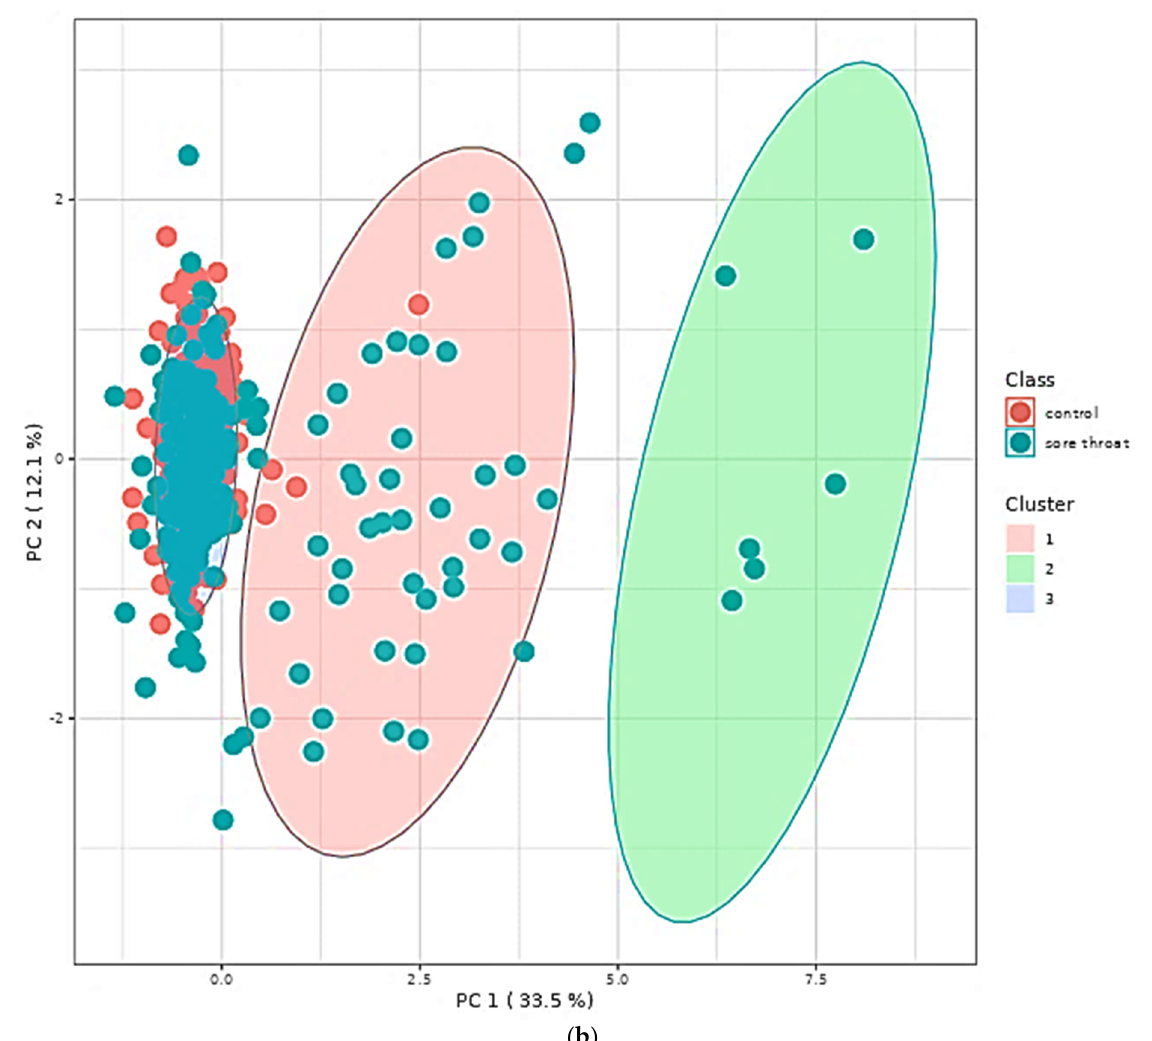
Figure 7. ( a ) Further segregation of the factor analysis (FA)-defined host source metabolite PC1 component (Ref. [1]) into two sub-components of 10 variables each via a secondary sPLS-DA strategy: PC2 versus PC1 and PC1 versus PC2 two-dimensional (2D) scores plots of results arising from this analysis of the acute sore throat disease dataset, with n = 480 participants (240 sore throat-positive, 240 age-matched healthy controls) and 31 1 H NMR-assigned biomolecules. Model 2 variance contributions for PC1 and PC2 were 26.9 and 11.2%, respectively. ( b ) PC2 versus PC1 2D scores plot of a composite PCA/k-means clustering analysis applied to the full Model 1 1 H NMR ISB dataset (183 variables in total). Estimated variance contributions for PC1 and PC2 were 33.5 and 12.1%, respectively.